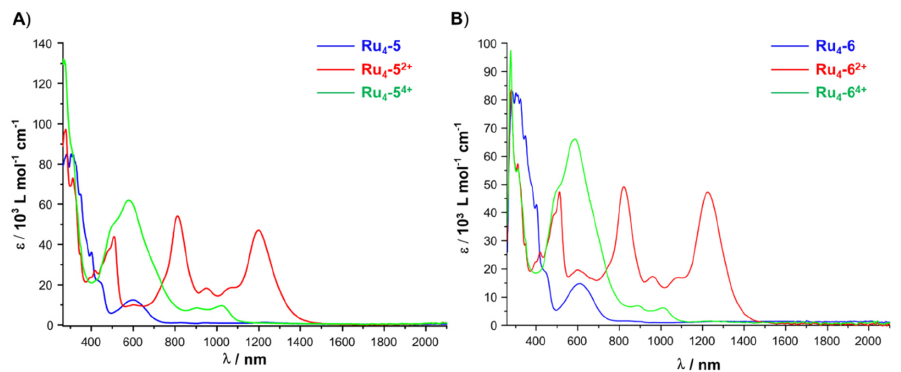
Figure 6. Spectroscopic changes in the UV–vis–NIR spectra of ( A ) Ru 4 -5 (blue) upon the oxidation to [ Ru 4 -5 ] 2+ (red) and [ Ru 4 -5 ] 4+ (green) and ( B ) of Ru 4 -6 (blue) upon oxidation to [ Ru 4 -6 ] 2+ (red) and [ Ru 4 -6 ] 4+ (green) in CH 2 Cl 2 at 298 K ( c = 80 mM). The dications [ Ru 4 -5 ] 2+ and [ Ru 4 -6 ] 2+ and tetracations [ Ru 4 -5 ] 4+ and [ Ru 4 -6 ] 4+ were obtained by treatment of the neutral macrocycle with 2 equivalents of ferrocenium hexafluorophosphate (Fc + PF 6 − ) or 4 equivalents of acetylferrocenium hexafluoroantimonate (AcFc + SbF 6 − ),